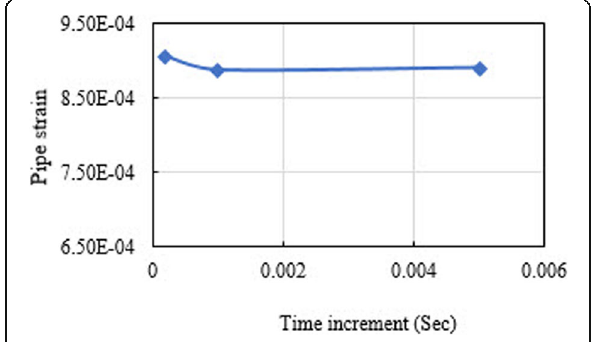
Fig. 2 Effect of time increment of input motion on maximum pipe strain